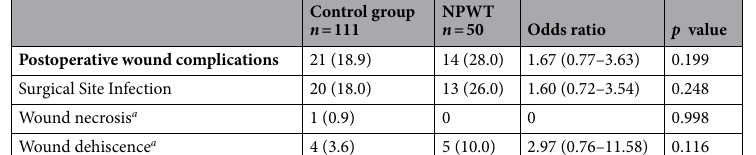
Control group n = 111